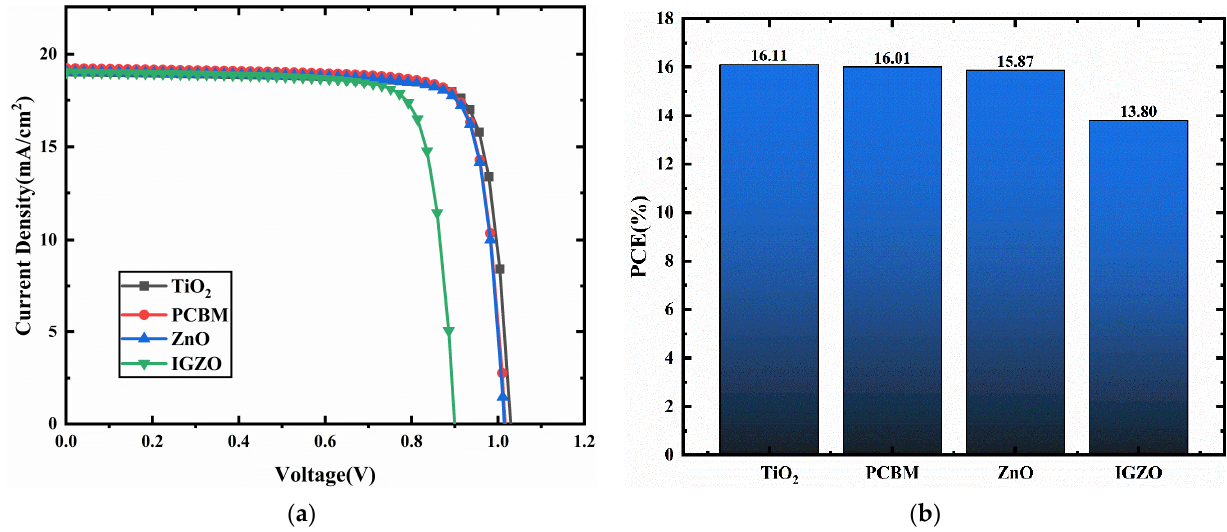
Figure 4. ( a ) Comparison of the J-V characteristic curves for different HTMs as HTL; ( b ) PCE for different ETMs as ETL. Table 5. Performance parameters of different ETMs as